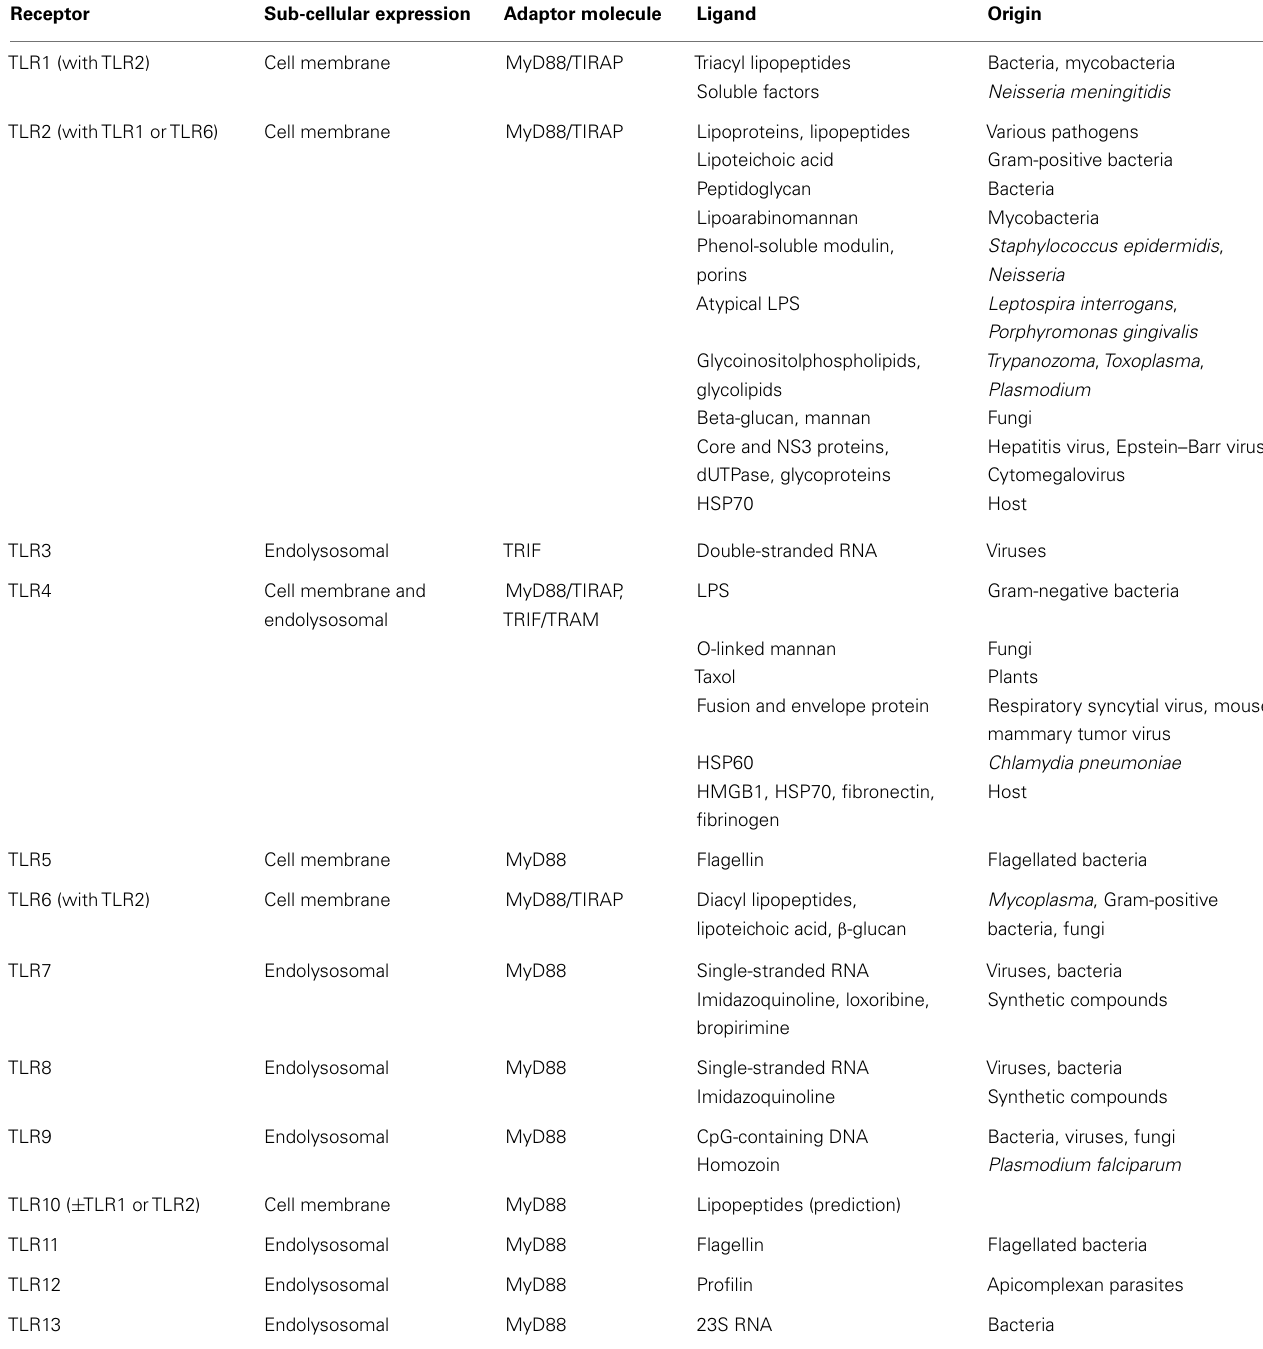
Table 1 |Toll-like receptors and their ligands